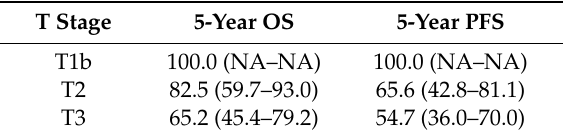
FIGO, International Federation of Gynecology and Obstetrics. OS, overall survival; PFS, progression- free survival; NA, not assessable. Data are % (95% confidence intervals).